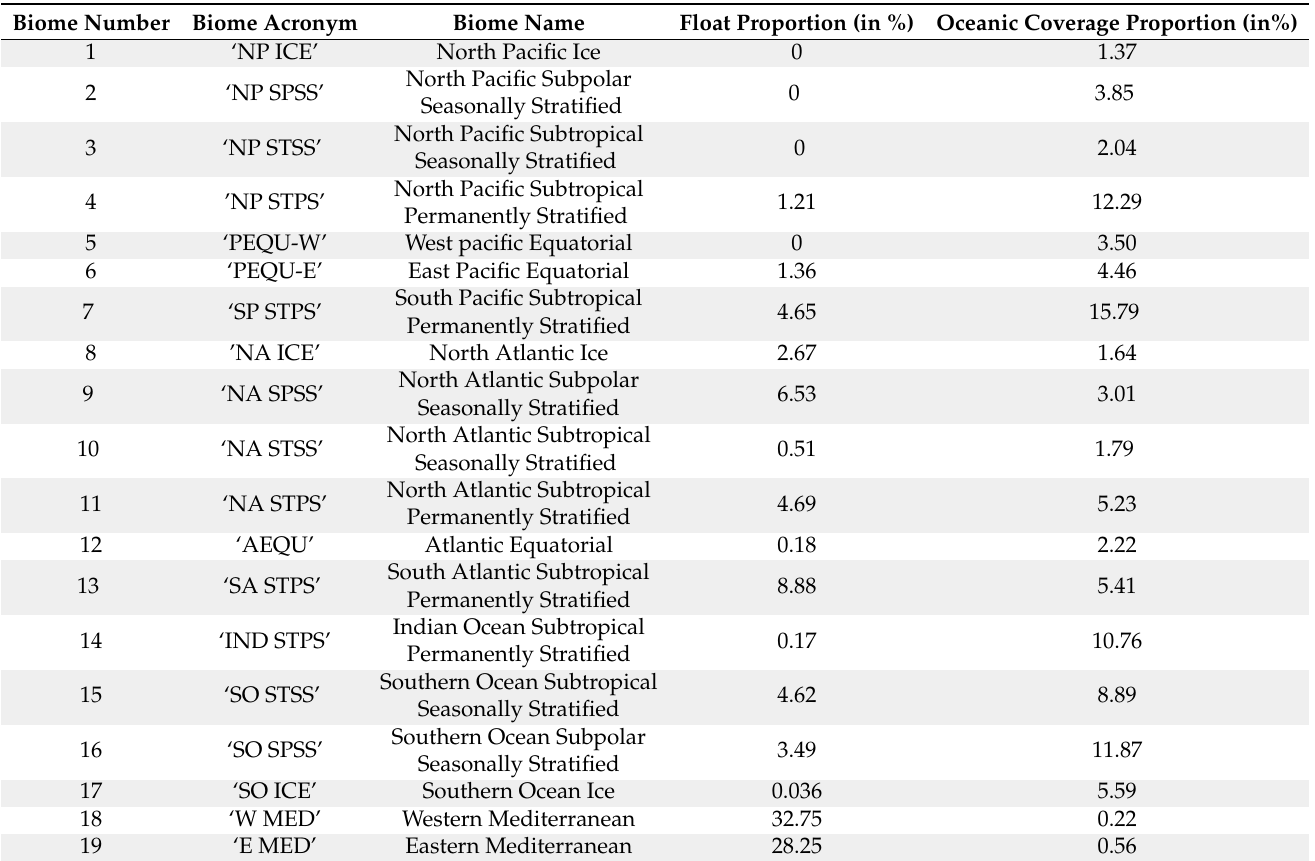
Table A2. List of the biomes according to Fay and McKinley, 2014, with the associated number. Biomes 18 and 19 were added for Mediterranean Sea with the East/West division at the Sicily Strait. Percentage of all profiles for all of the float-sensors matchups grouped together, regardless of wavelength. Oceanic coverage proportion is area relative to the area covered by all the biomes grouped